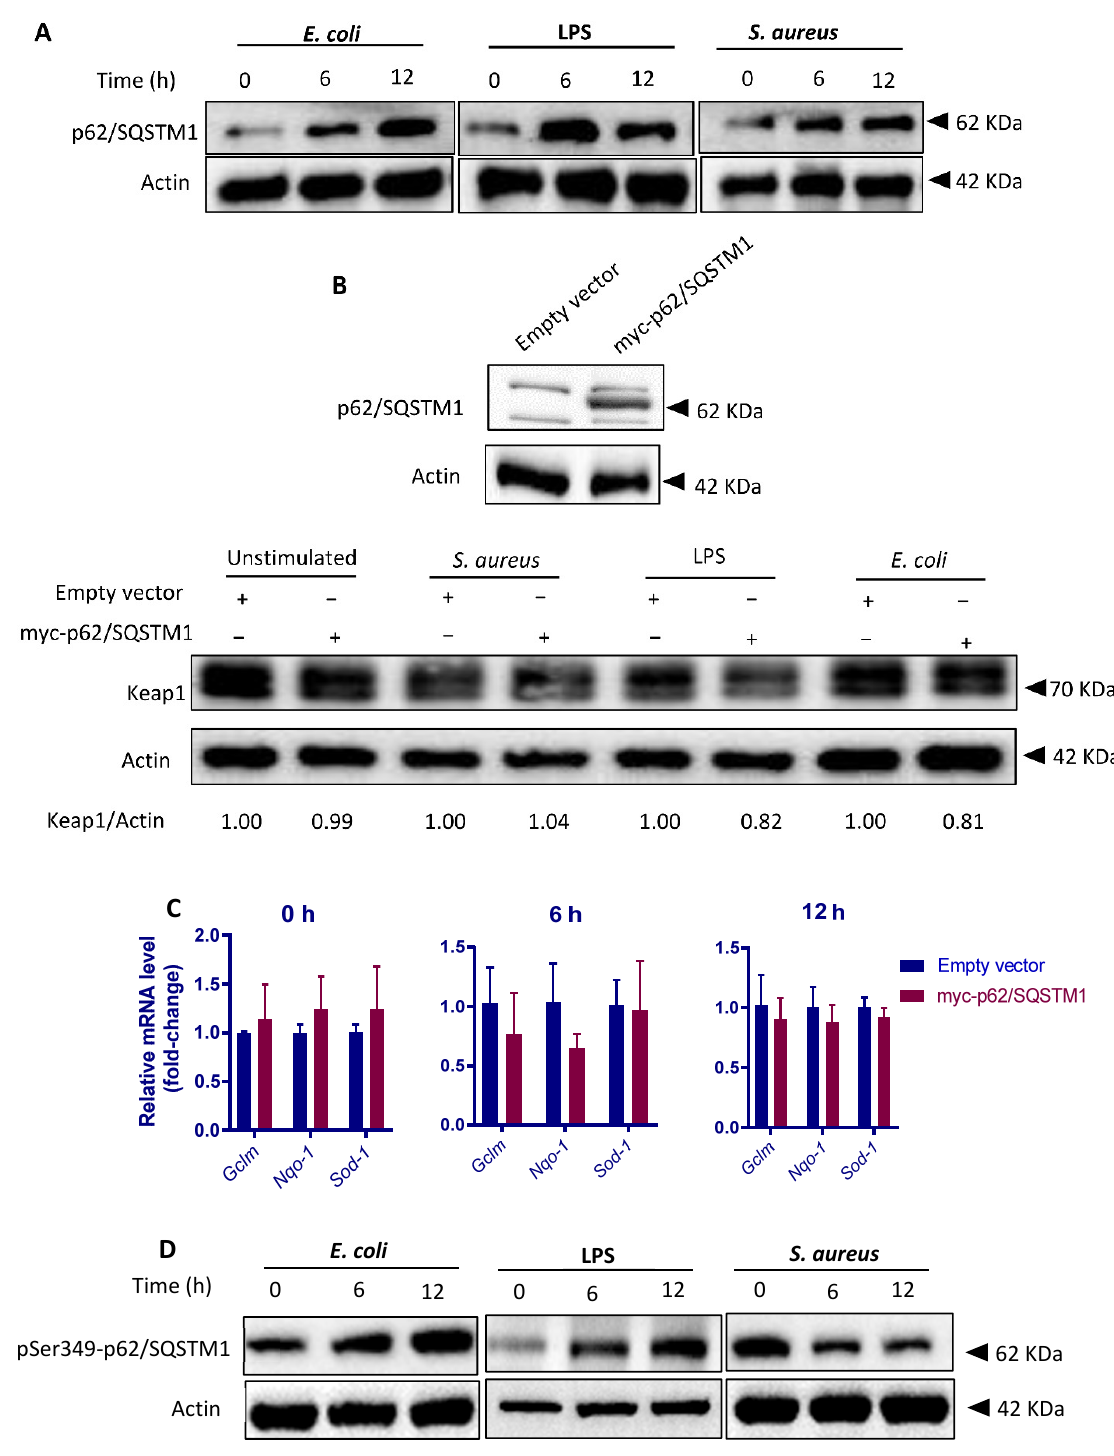
Figure 10. S. aureus and E. coli differentially modify p62/ SQSTM1 phosphorylation . ( A ) Evaluation of the p62/SQSTM1 protein levels in pbMECs. Cells were treated with heat-killed E. coli (1 × 10 7 particles /mL), LPS (10 µ g/mL) or S. aureus (1 × 10 7 particles/mL) for the indicate time. Whole-cell extracts were analysed by immunoblotting with anti-p62/SQSTM1. β -actin is shown as a loading control. The data are representative of 2 independent experiments. ( B ) Evaluation of the p62/SQSTM1-dependent Keap1 degradation. pbMECs were transfected with either mock (empty vector) or myc- p62/SQSTM1 plasmid. Forty-eight hours post-transfection, the cells were treated heat-killed E. coli (1 × 10 7 particles /mL), LPS (10 µ g/mL) or S. aureus (1 × 10 7 particles/mL) for a further 6 h. Whole-cell extracts were analysed by